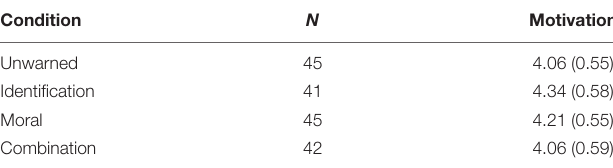
TABLE 3 | Means and SD of motivation.